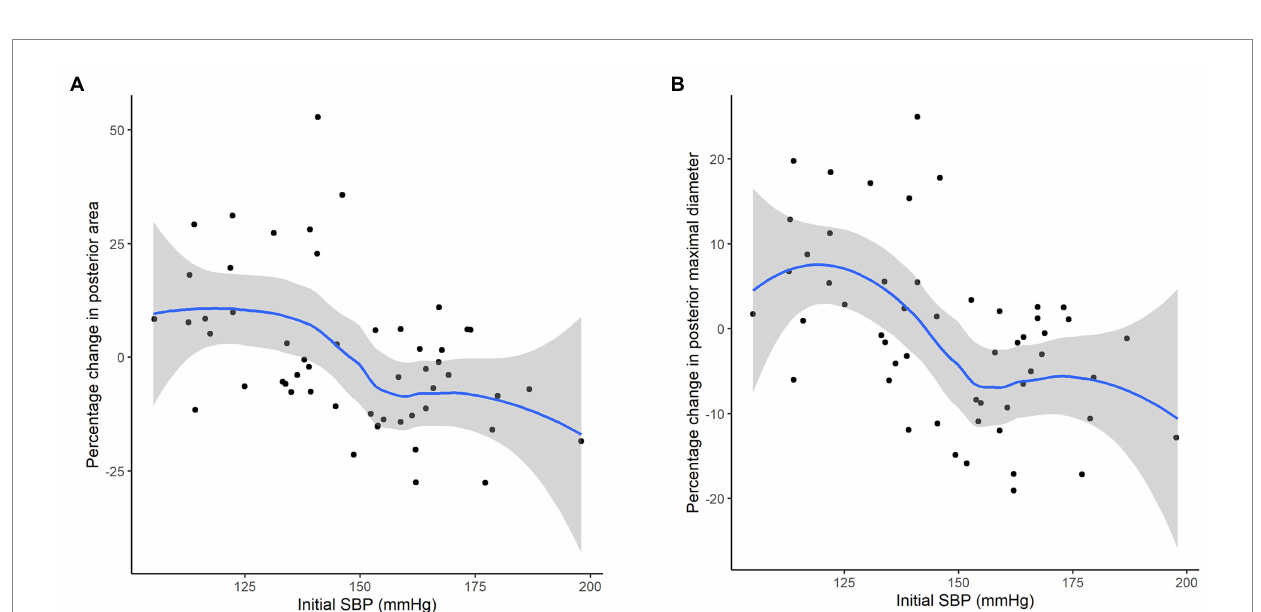
FIGURE 4 Correlation between initial SBP on the percent changes of arterial luminal area (A) and the maximum diameter (B) . The plots were generated by the approximated polygonal curve approximation for the